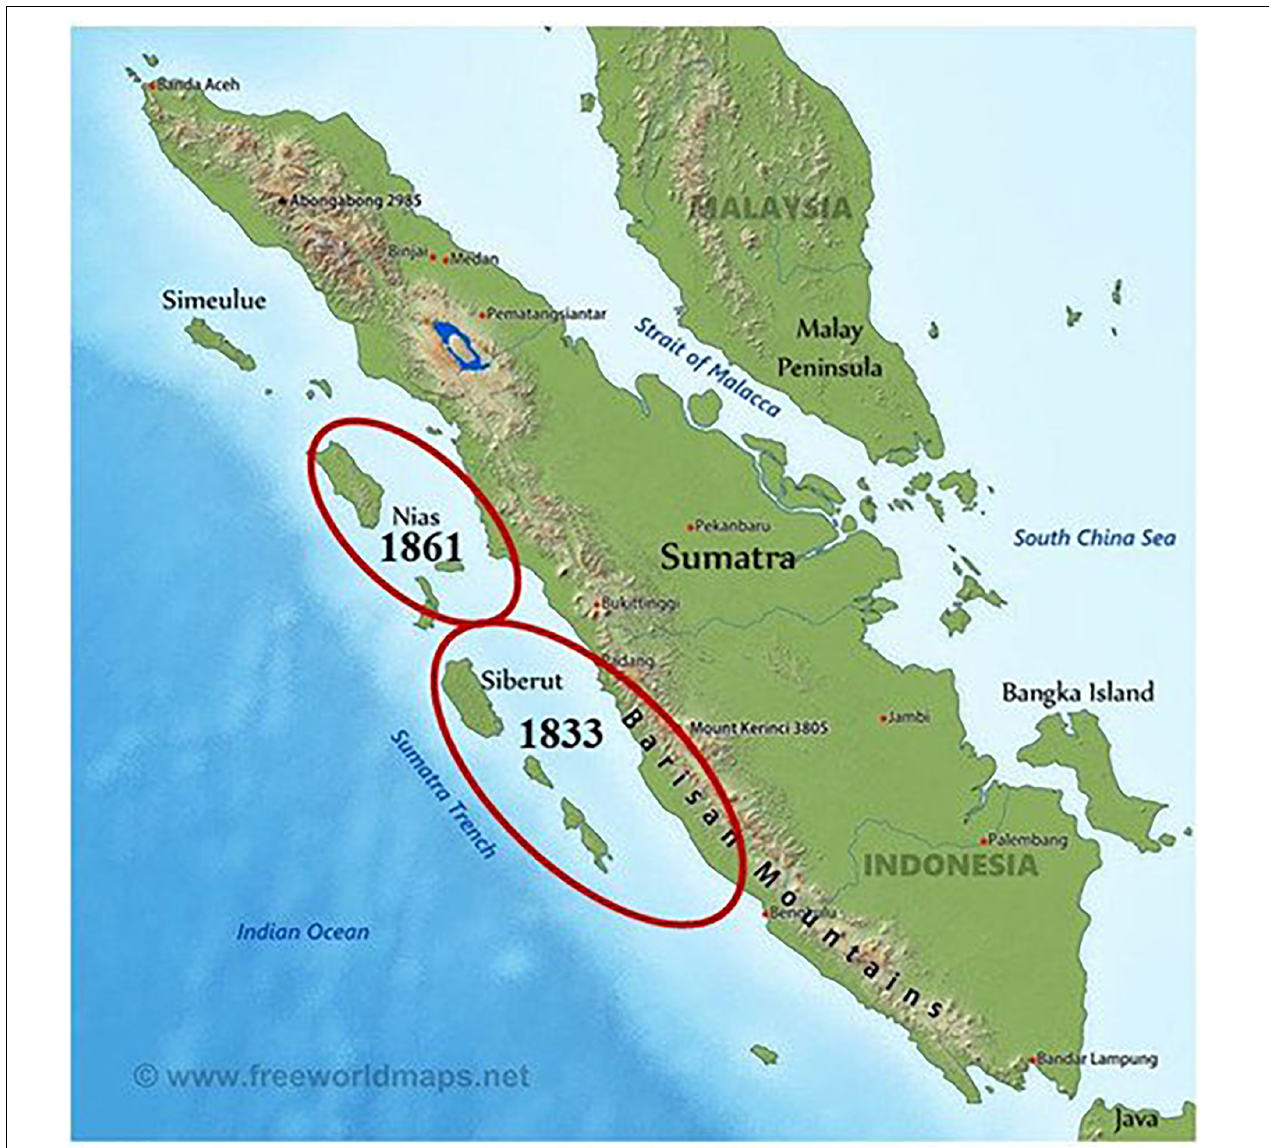
FIGURE 2 | Map of Sumatra showing the earlier 1833 and 1861 earthquake ruptures. Aceh, the site of prehistoric tsunami deposits, is at the northernmost tip of